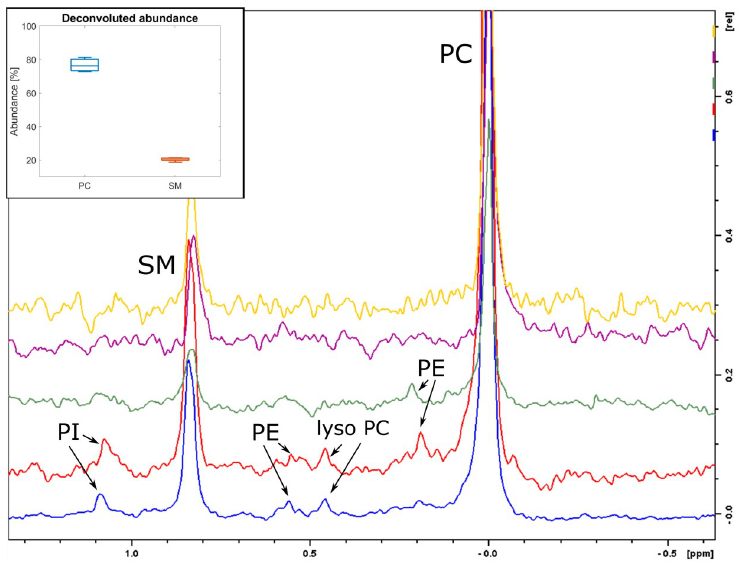
Fig 3. 31 P NMR spectra of EV lipids. Lipids isolated from EVs was analyzed for phospholipid content by 31 P NMR (Bruker NEO 600 MHz) and the most common phospholipids were identified. Figure insert: Box plot of the relative abundances determined by deconvolution of NMR spectra for the two most abundant phospholipids.